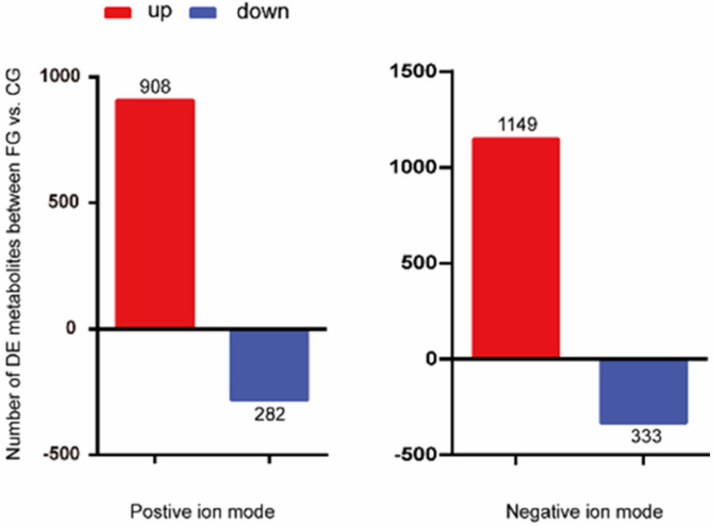
Figure 4. Differential metabolites between cage-reared ducks and floor-reared ducks under positive and negative ion modes. FG, floor-reared duck; CG, cage-reared duck.